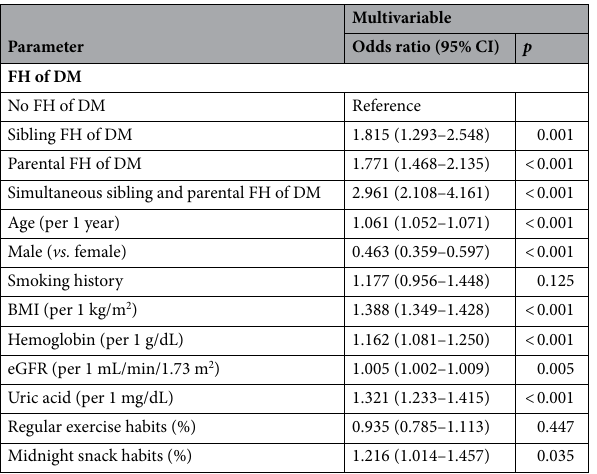
Table 2. Determinants of MetS using multivariable logistic regression analysis. Values expressed as odds ratio and 95% confidence interval (CI). Abbreviations are the same as in Table 1. Adjusted for study groups of FH of DM, age, sex, smoking history, BMI, hemoglobin, eGFR, uric acid, regular exercise and midnight snack habits.